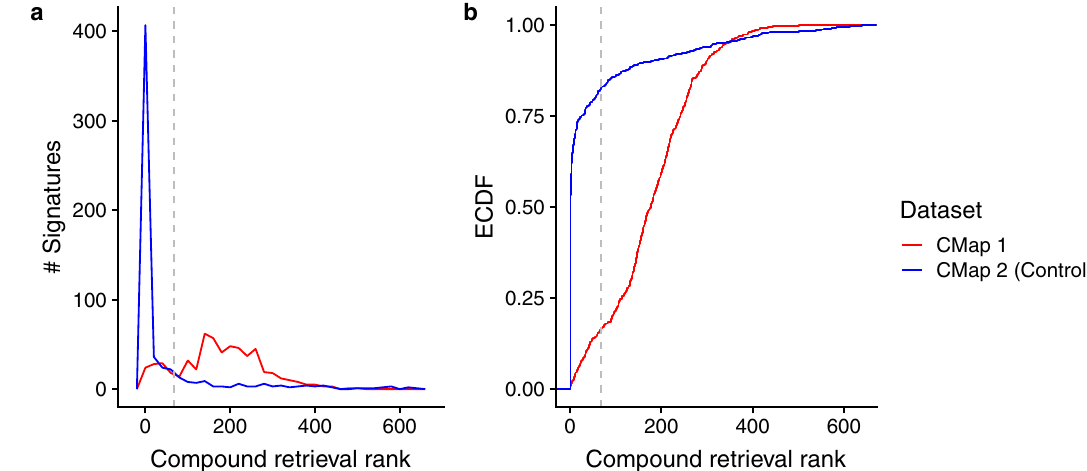
Figure 1. Distribution of compound retrieval ranks (1 is best, x-axis) from querying CMap 2 using signatures derived from CMap 1 (red lines) or CMap 2 (blue lines; self-query) data, (N = 588). Panel ( a ) shows the distribution while ( b ) is the empirical cumulative distribution function (ECDF) of the same results. The dotted grey line indicates the profiles where the query compound is ranked in the top 10% (rank ≤